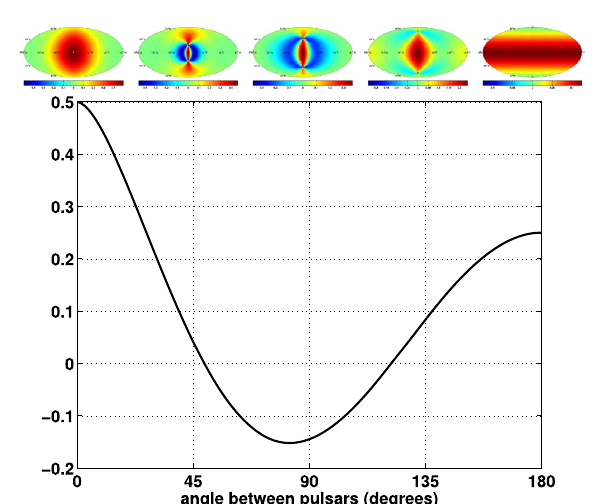
Fig. 44 Top row Mollweide projections of γ( ˆ n ) for pairs of pulsars separated on the sky by ζ = 0 ◦ , 45 ◦ , 90 ◦ , 135 ◦ , 180 ◦ . Reddish regions correspond to positive values of γ( ˆ n ) ; blueish regions correspond to negative values of γ( ˆ n ) . Bottom Hellings and Downs curve as a function of the angular separation between two distinct pulsars. The integral of the top plots over the whole sky equal the values of the Hellings and Downs curve for these angular separations. (See also Fig.